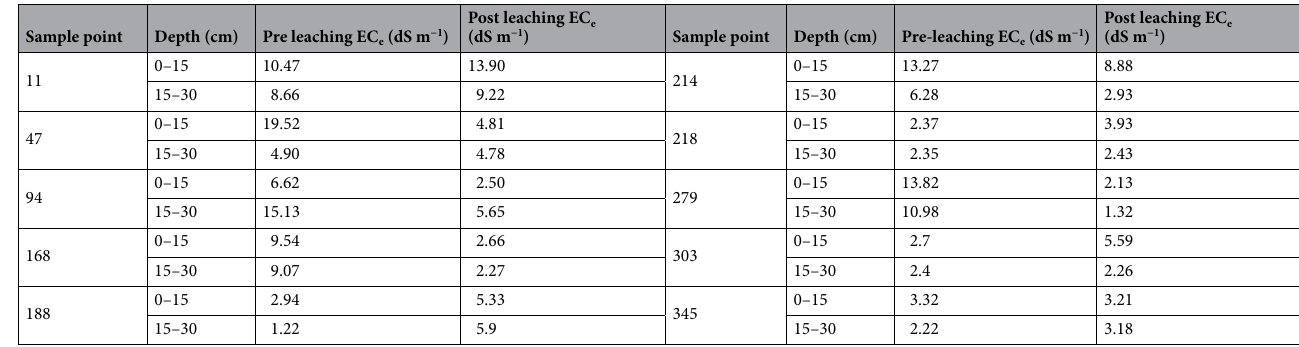
Table 2. Soil salinity at the sampling points for pre and post leaching for fairway